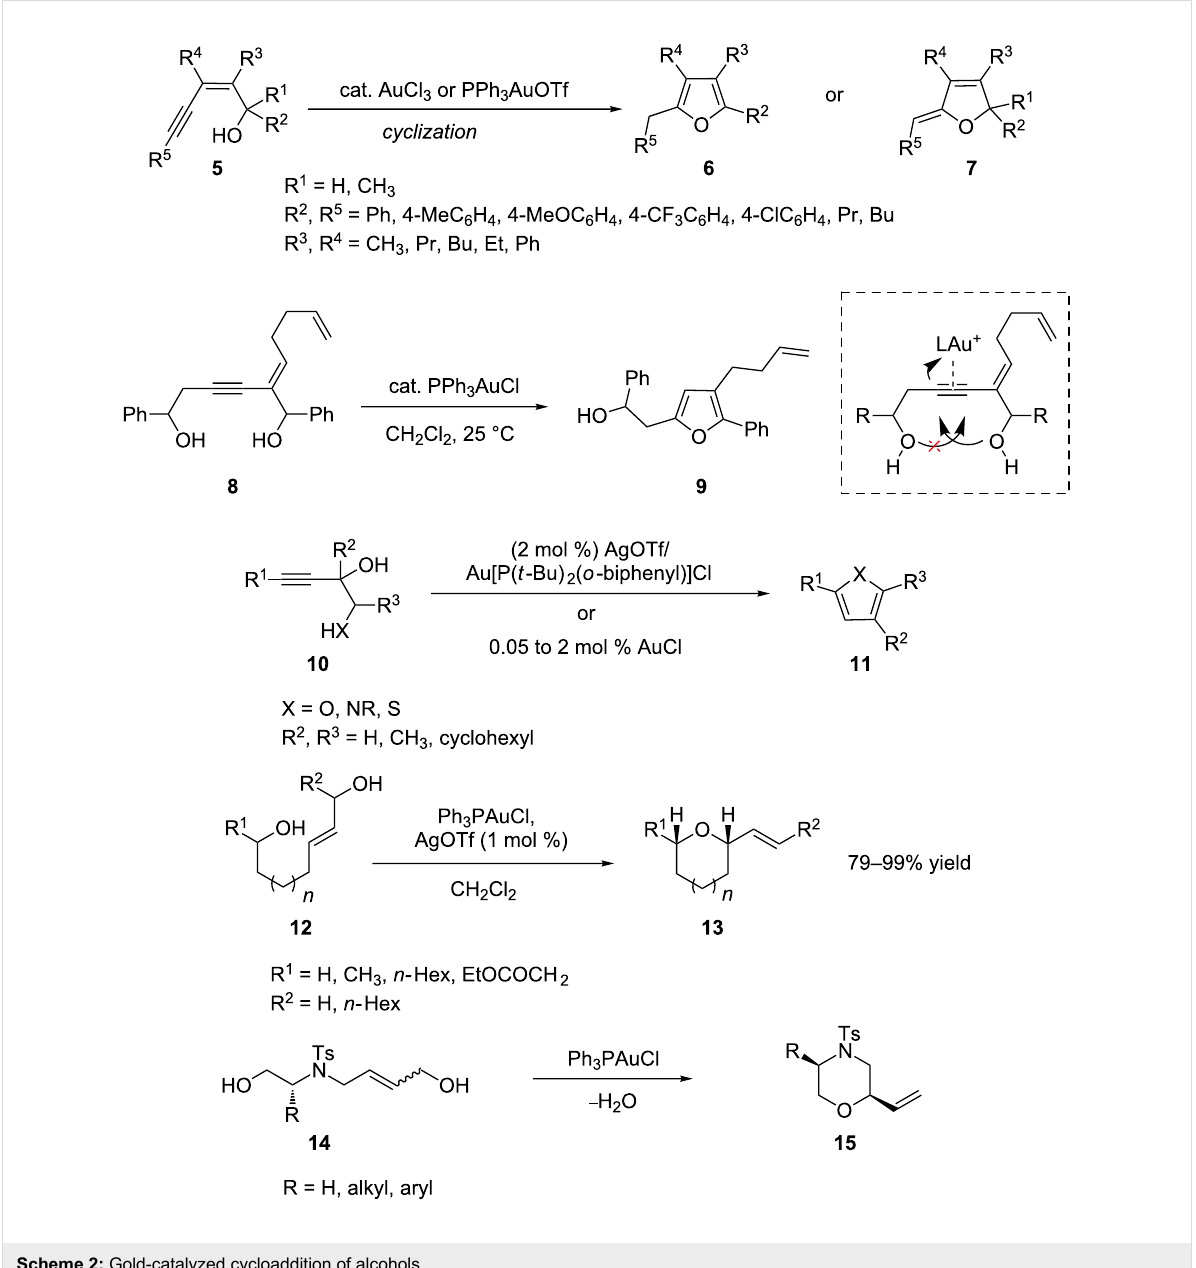
Scheme 2: Gold-catalyzed cycloaddition of alcohols.